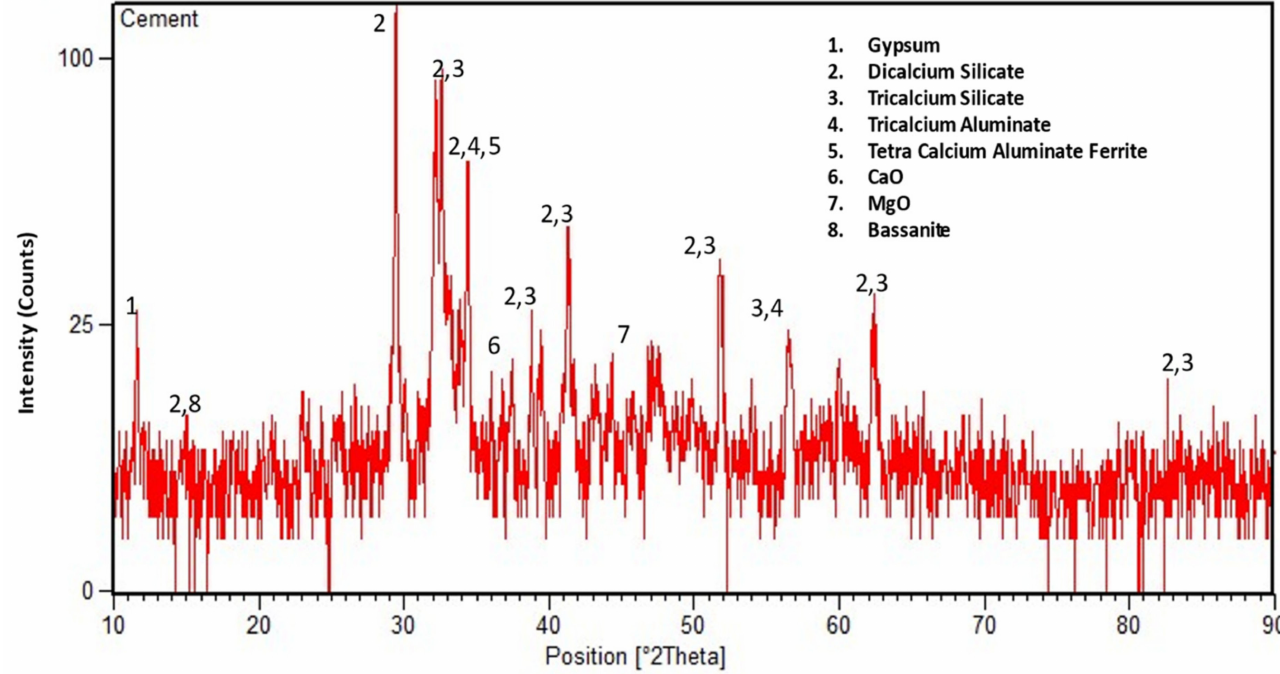
Figure 1. X-ray diffraction of ordinary Portland cement (OPC) Type-I.